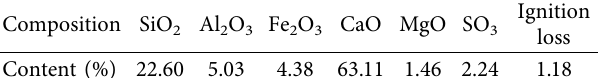
Table 1: Chemical composition of